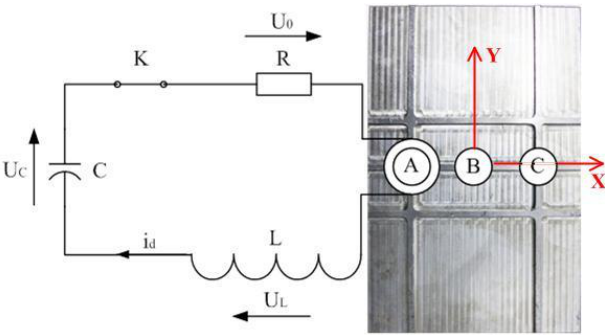
Figure 6. Defined coordinate system of the workpiece.